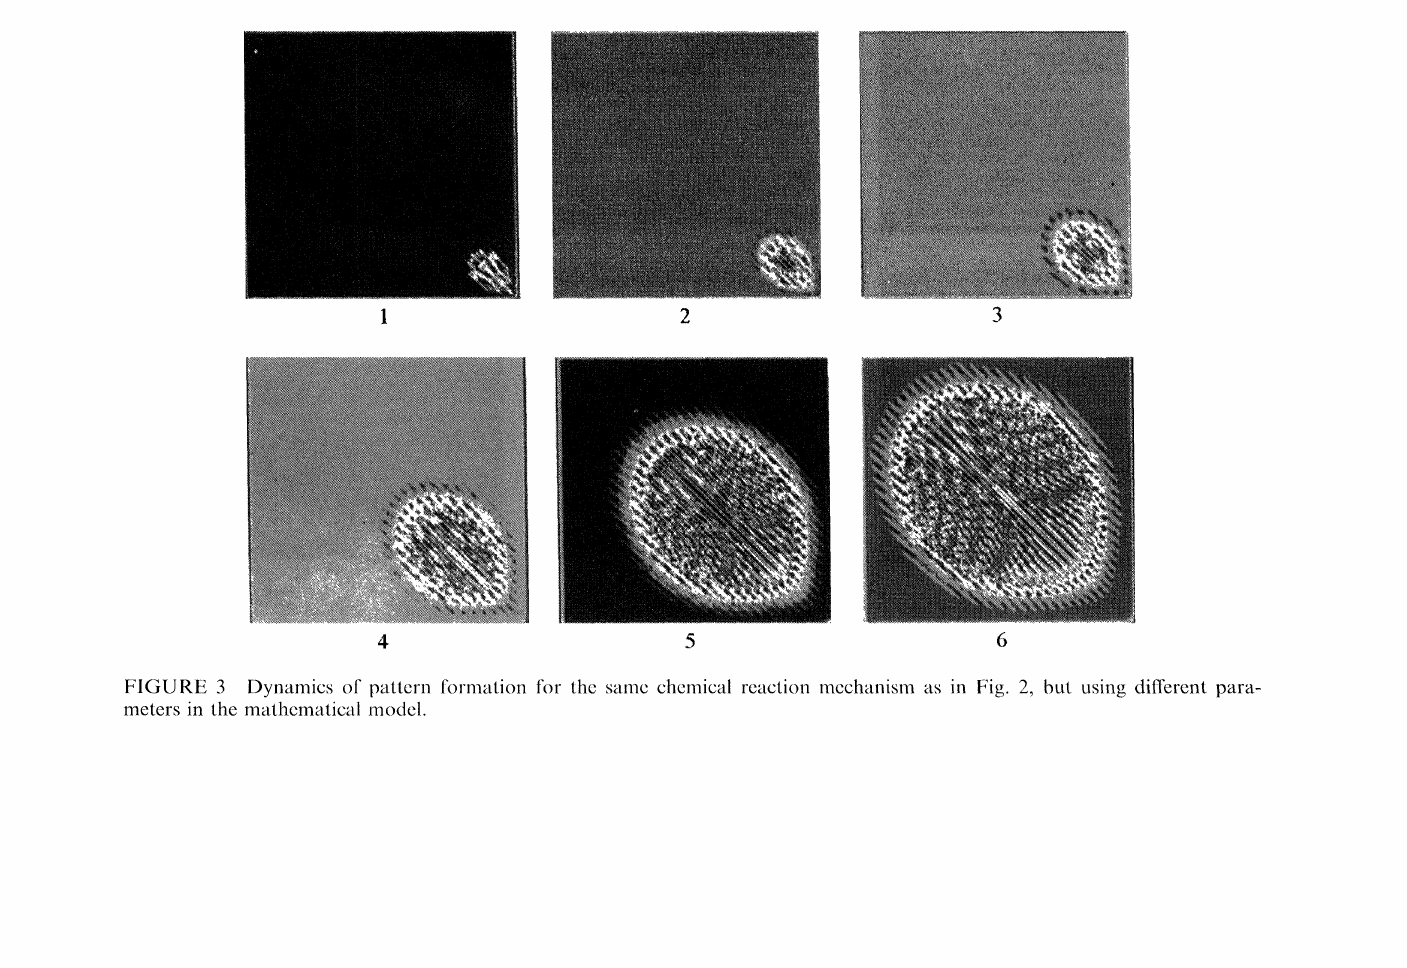
FIGURE 2 Dynamics of pattern formation, obtained using new basic equations for the chemical reaction mechanism: A B--, C. represents the 50th iteration; 2 the 100th; etc.